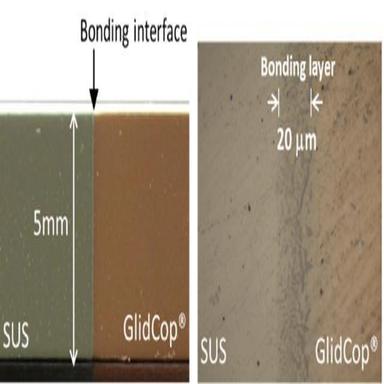
Photograph (left side) and optical microscope (right side) images of the SUS/ GlidCop® joint with load of ~0.54 MPa during the heat treatment procedure.